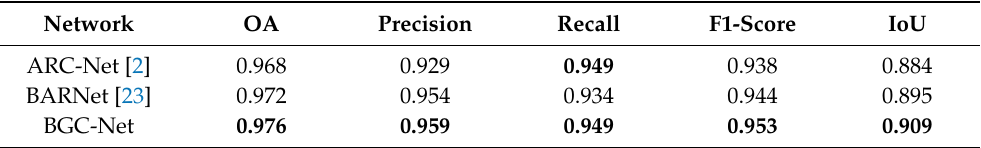
Figure 15. Building extraction results of different networks on the WHU dataset. ( a ) Original image. ( b ) Ground truth. ( c ) ARC-Net. ( d ) BARNet. ( e ) BGC-Net. Note, in Columns ( b – e ), black, white, green, blue, and red indicate true, false, true-positive, false-negative, and false-positive, respectively. Table 5. Average accuracy of different networks for building extraction on WHU dataset. The best scores are highlighted in bold.